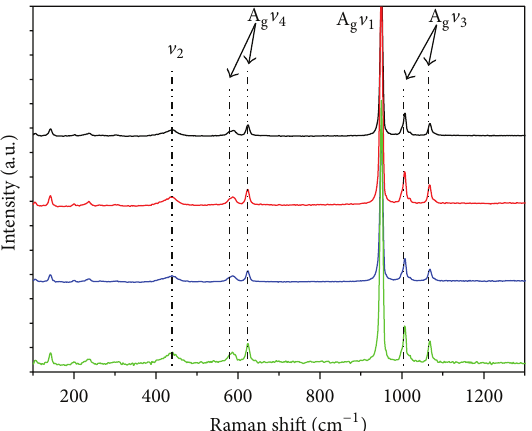
Figure 7: Raman spectrum for LiMnPO 4 synthesized with various parameters: (a) 190 ∘ C [H 2 O]/[Mn] = 30 (sample B), (b) 190 ∘ C